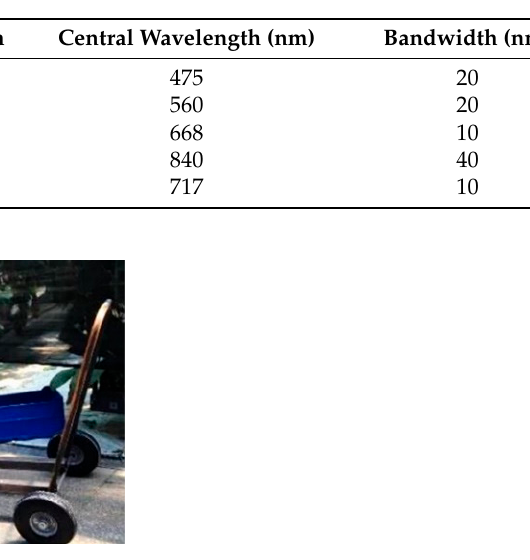
Figure 2. Mobile cart and adjustable metallic extension indicating the point where the MicaSense ® RedEdge camera was placed to collect multispectral images over cucumber plants inside a green- house.